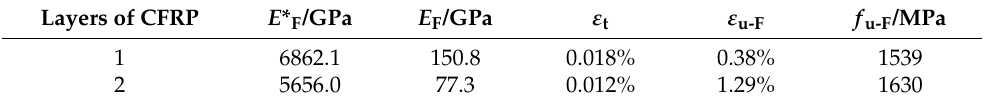
Table 5. Average values of the tensile mechanical properties of FRCM plates.